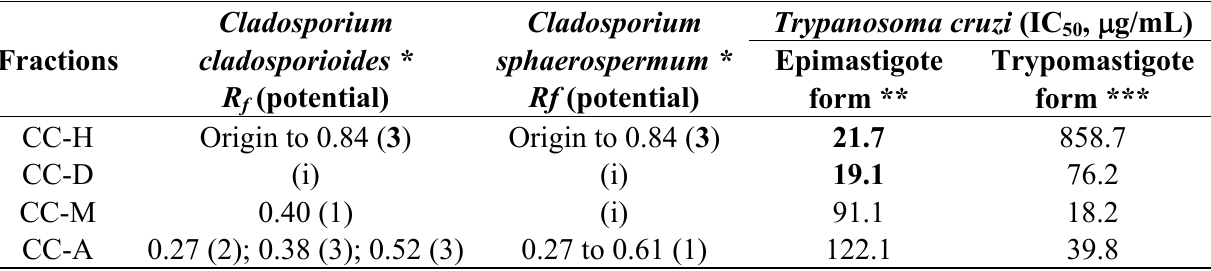
Table 2. Trypanocidal and antifungal activities of fractions from Centroceras clavulatum (Ceramiales,